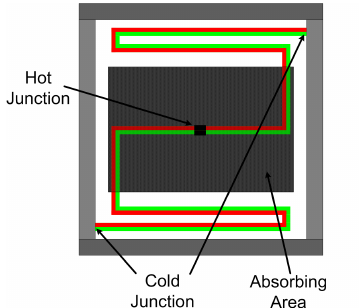
Figure 6. Schematic representation of the proposed thermopile